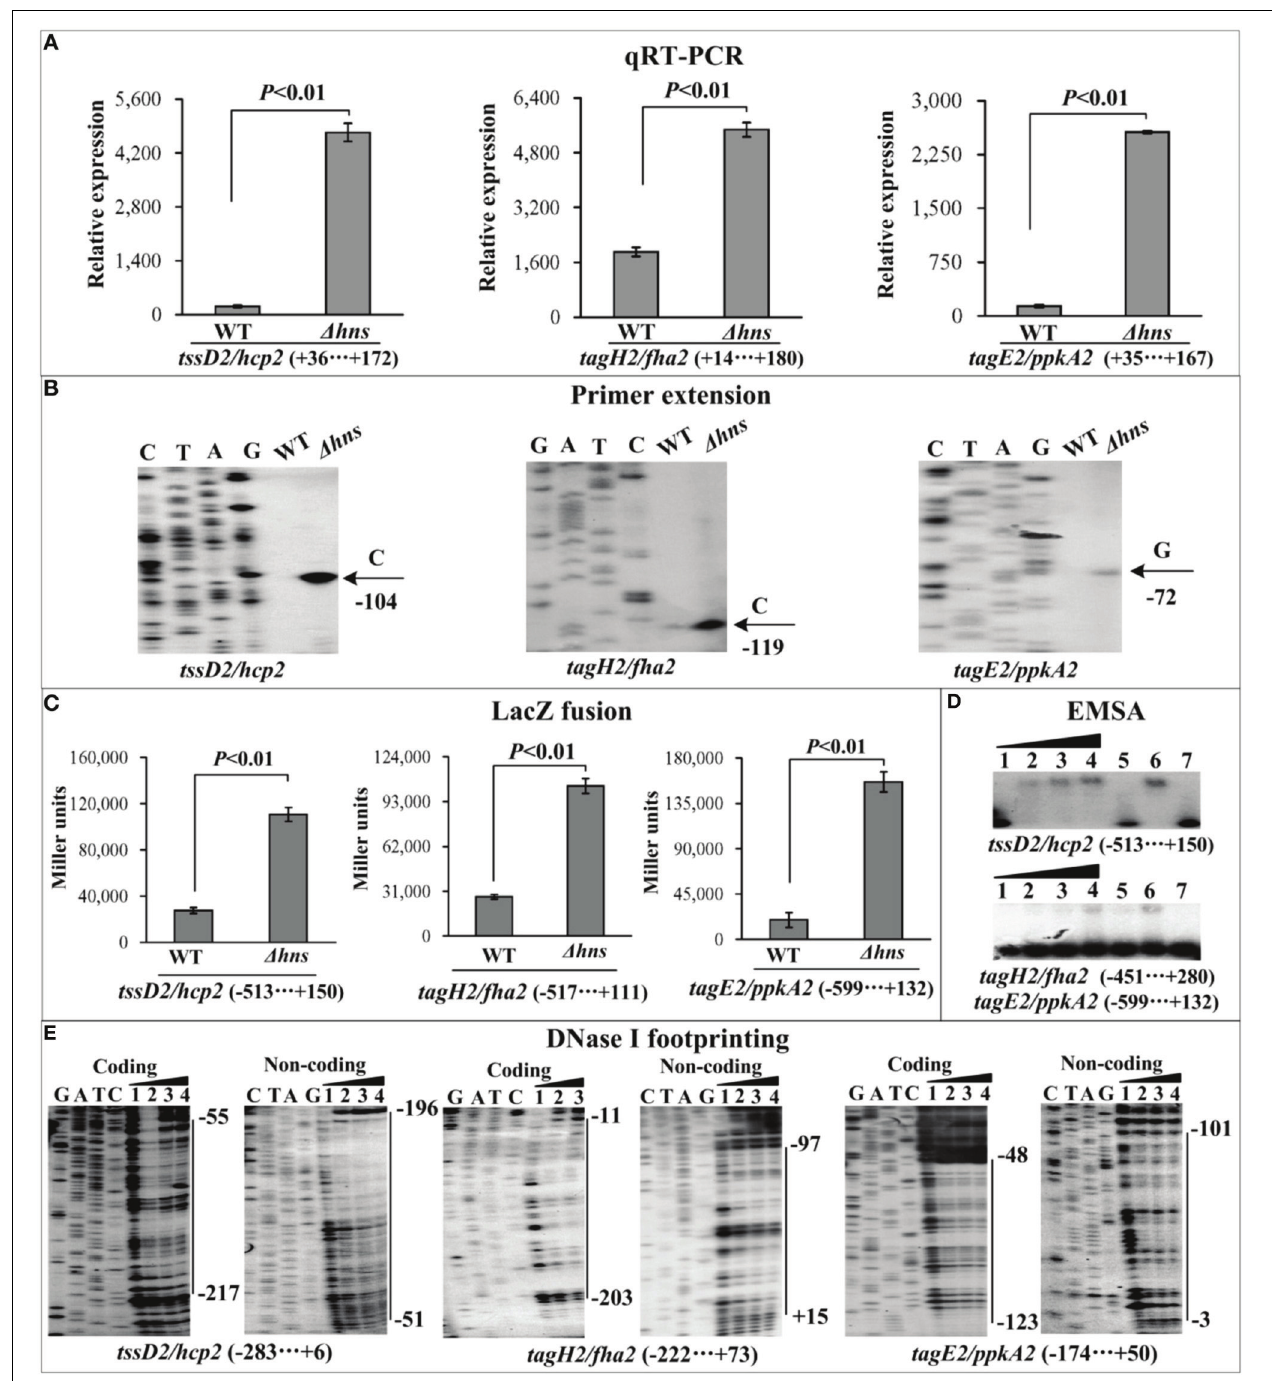
FIGURE 4 | Regulation of T6SS2 genes by H-NS. qRT-PCR (A) , primer extension (B) , LacZ fusion (C) , EMSA (D) , and DNase I footprinting (E) were performed as Figure 2 .